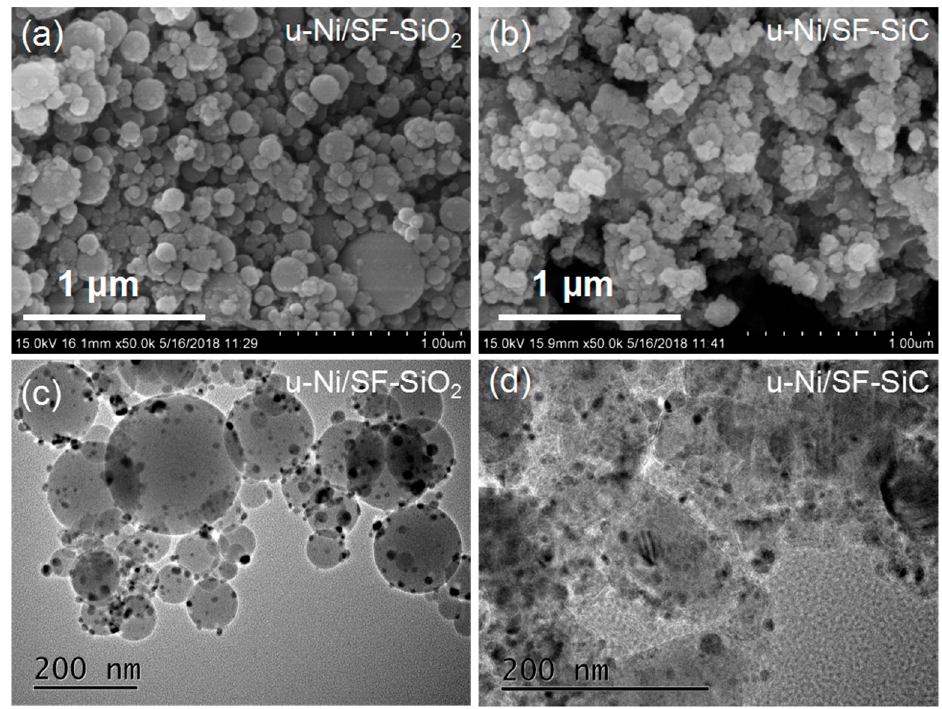
Figure 7. SEM images of the samples: ( a ) Used Ni/SF ‐ SiO 2 , ( b ) used Ni/SF ‐ SiC. HRTEM images of ( c ) used Ni/SF ‐ SiO 2 and ( d ) used Ni/SF ‐ SiC.